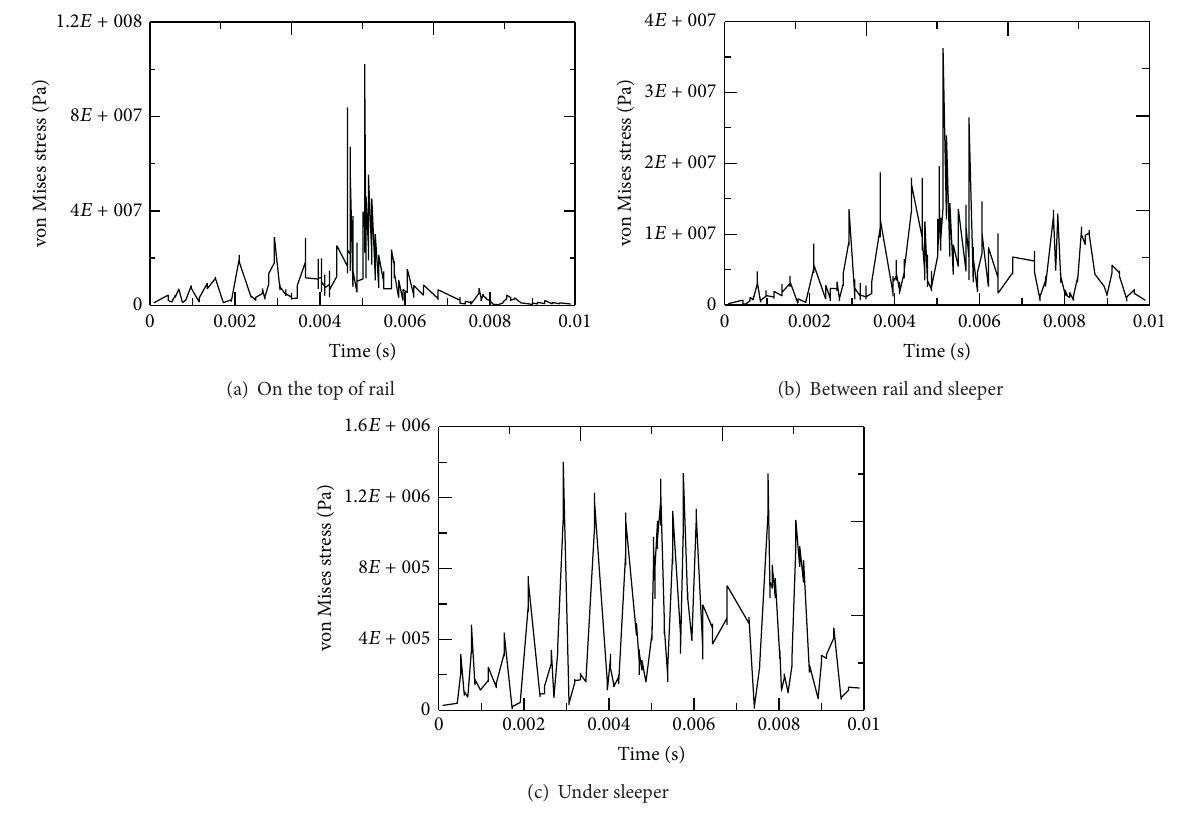
Figure 5: Time history of contact stress figure.